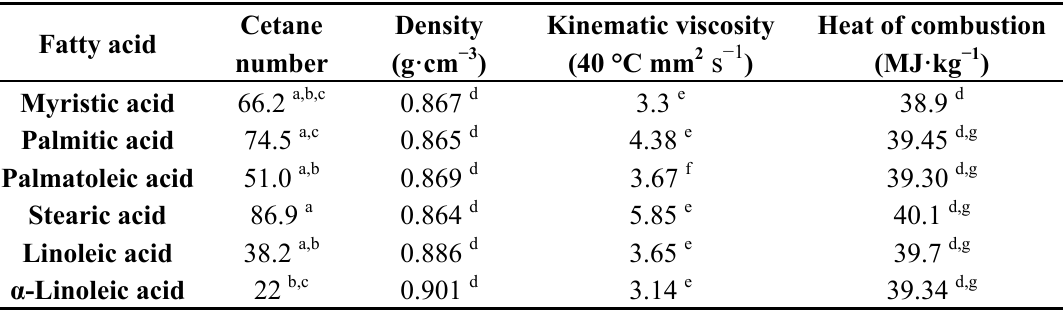
Table 4. Physical properties of common FAMEs.